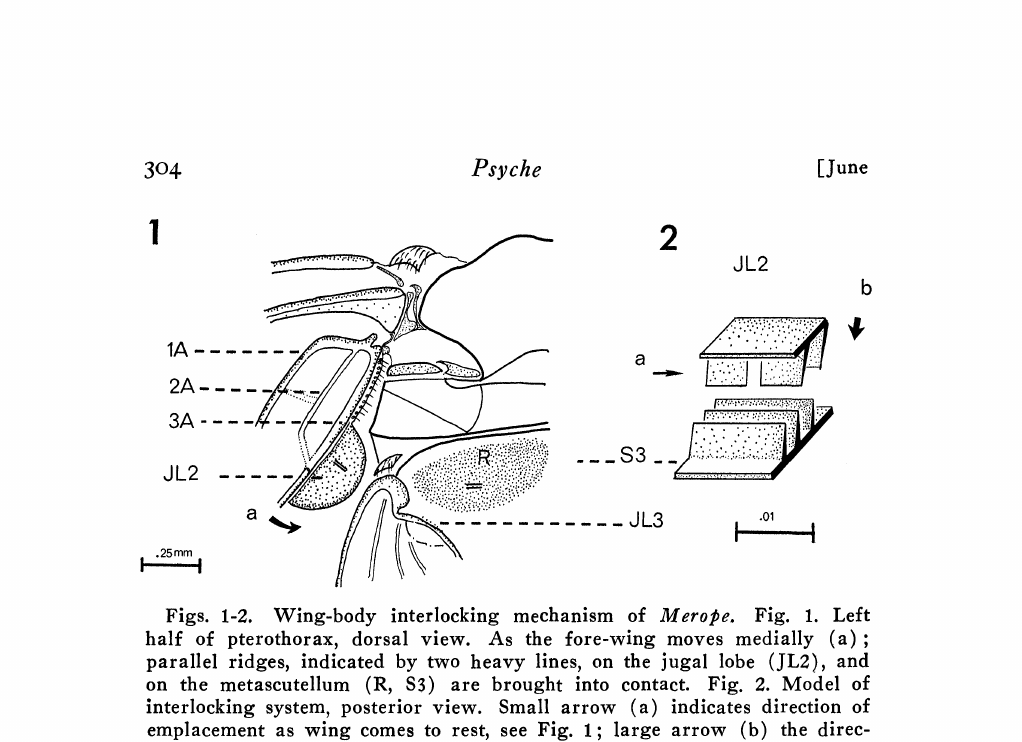
Figs. 1-2. Wing-body interloeking mechanism o{ Merole. Fig. 1. Left half of pterothorax, dorsal view. As the tore-wing moves medially (a); parallel ridges, indieated by two heavy lines, on the jugal lobe (JL2), and on the metaseutellum (R, $3) are brought into contact. Fig. 2. Model of interlocking system, posterior view. Small arrow (a) indicates direction of emplacement as wing comes to rest, see Fig. 1; large arrow (b) the direc- tion ot intermeshing of the slanted ridges. 1A, 2A, 3A, anal veins; JL2, JL3, meso- and metajugal lobes; R, ridge bearing patch ot metaseutellum, $3; a, direction of wing movement; b, direction of